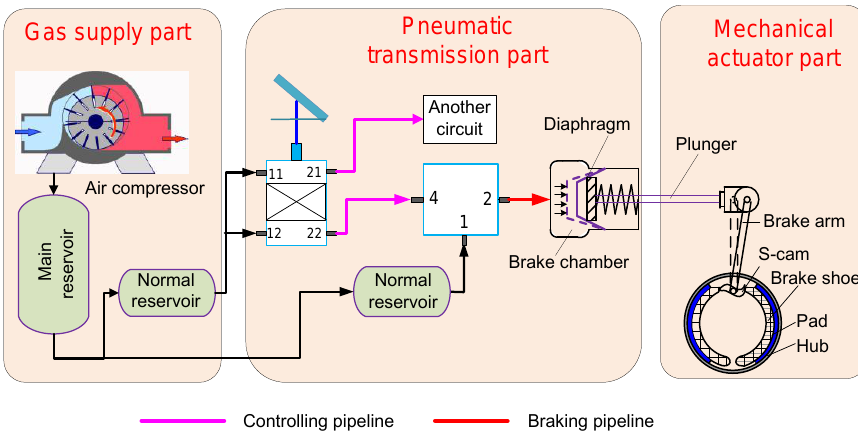
Figure 2. Structure of the service brake circuit of a